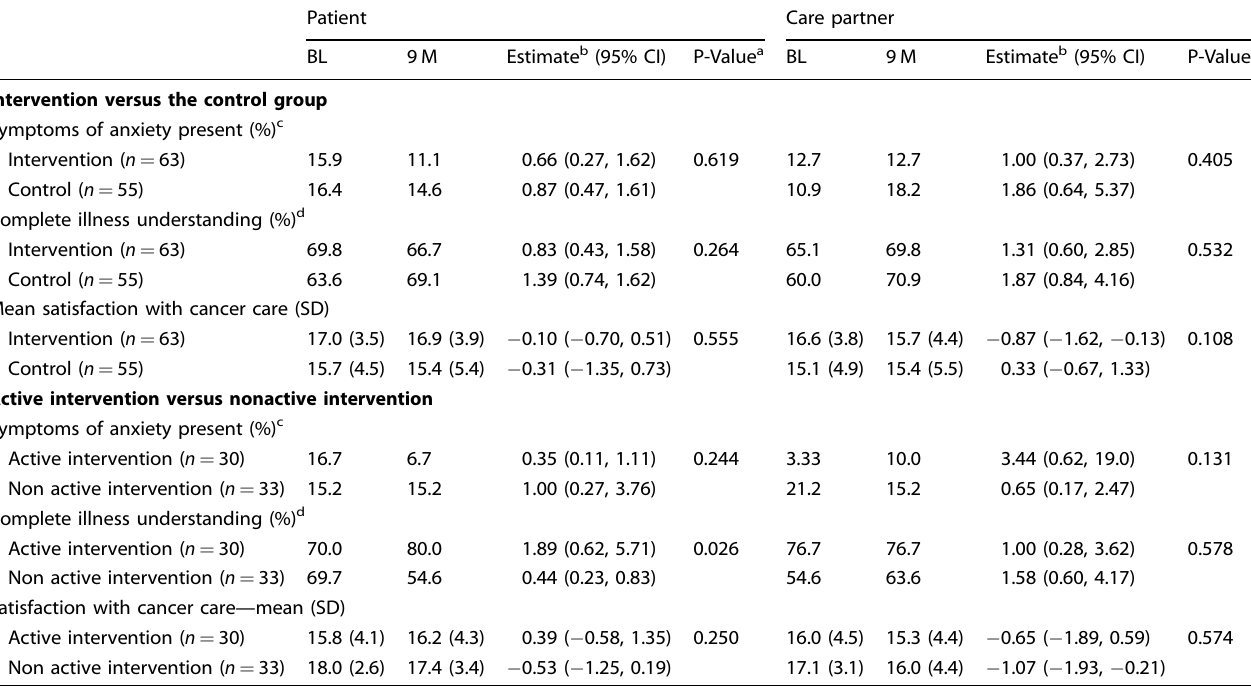
Table 3. Comparison of outcomes at 9 months by group assignment and intervention care partners ’ Use of